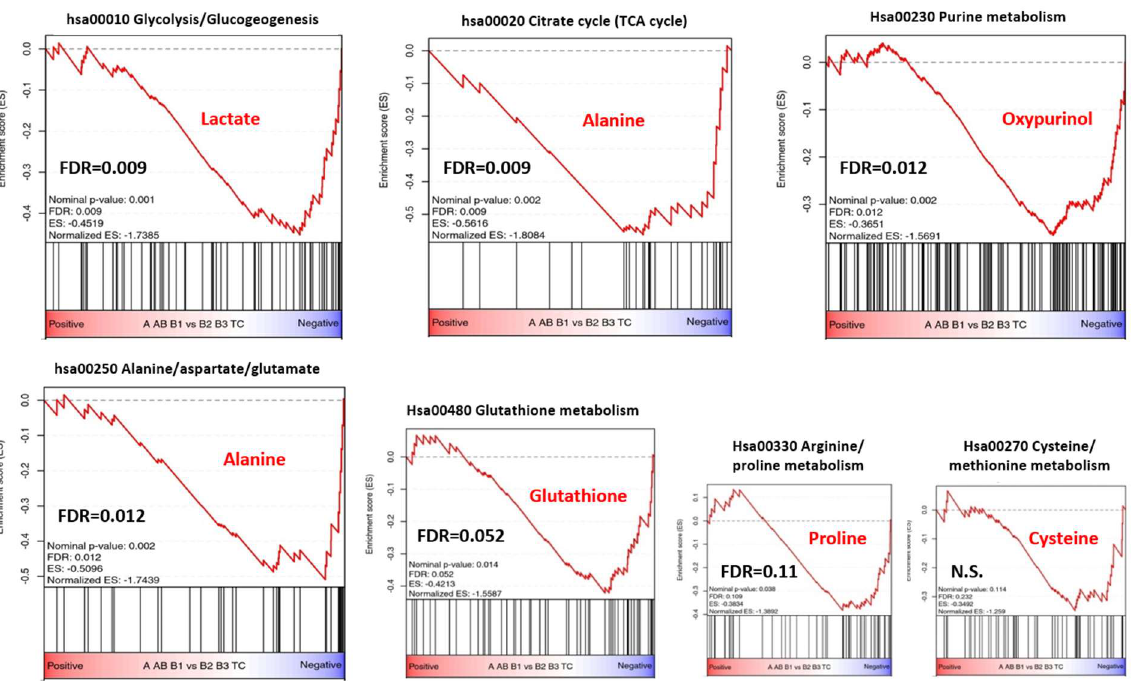
Figure 5. Gene set enrichment analysis (GSEA) of the indicated KEGG pathways comparing transcriptomic profiles of the group of indolent (A1, AB, and B1 thymomas) and aggressive thymic epithelial tumors (TETs) (B2 and B3 thymomas and thymic carcinomas, TC) as extracted from the TCGA, PanCancer Atlas dataset. Corresponding “key metabolites” identified in the HRMAS 1 H-NMR-based analysis (Table 2) are given in red. Alanine as “key metabolite” was assumed to be functionally linked to two KEGG pathways: The TCA cycle and the alanine/aspartate/glutamate pathway. In addition to the Hsa00270 Cysteine/methionine pathway, the Hsa00260 Glycine/serine/threonine pathway (not shown) was also not enriched. Of note, the selection of the purine metabolism pathway in relation to high oxyurinol levels is only a hypothesis, since it is unknown whether oyxpurinol is an endogenous metabolite of purine metabolism or derived from an unknown food ingredient (we excluded allopurinol as a source of oxypurinol in the respective patients through clinical history). FDR, false detection rate.